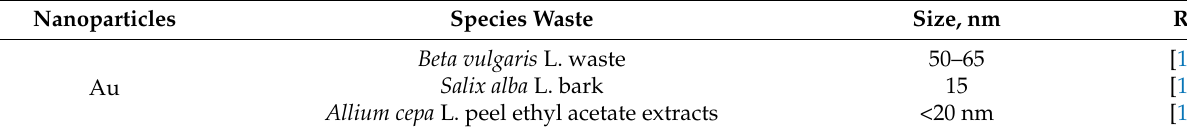
Table 8. Examples of periderm extract utilization for production of